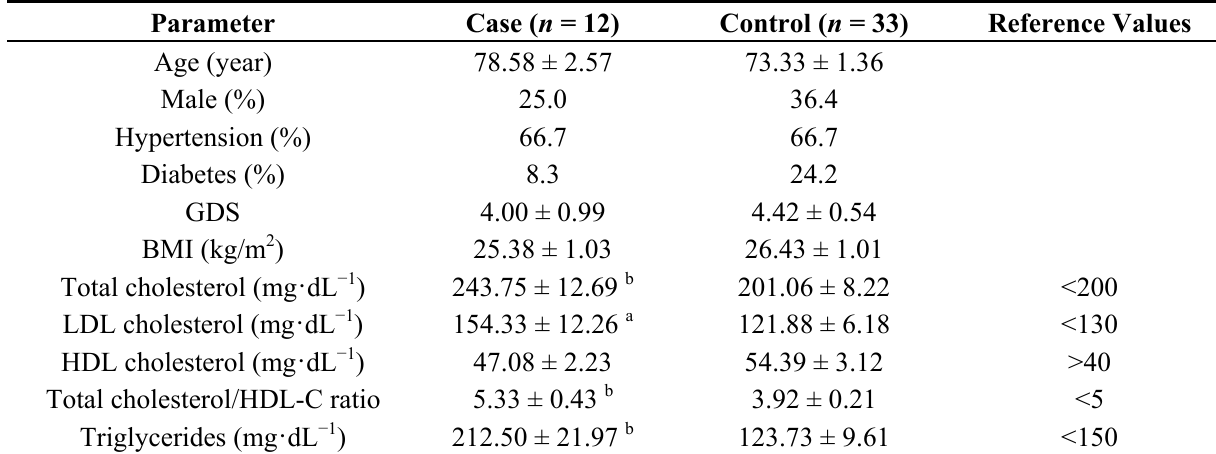
Table 1. Baseline characteristics of the elderly: the case group (with cognitive impairment) and control group (without cognitive